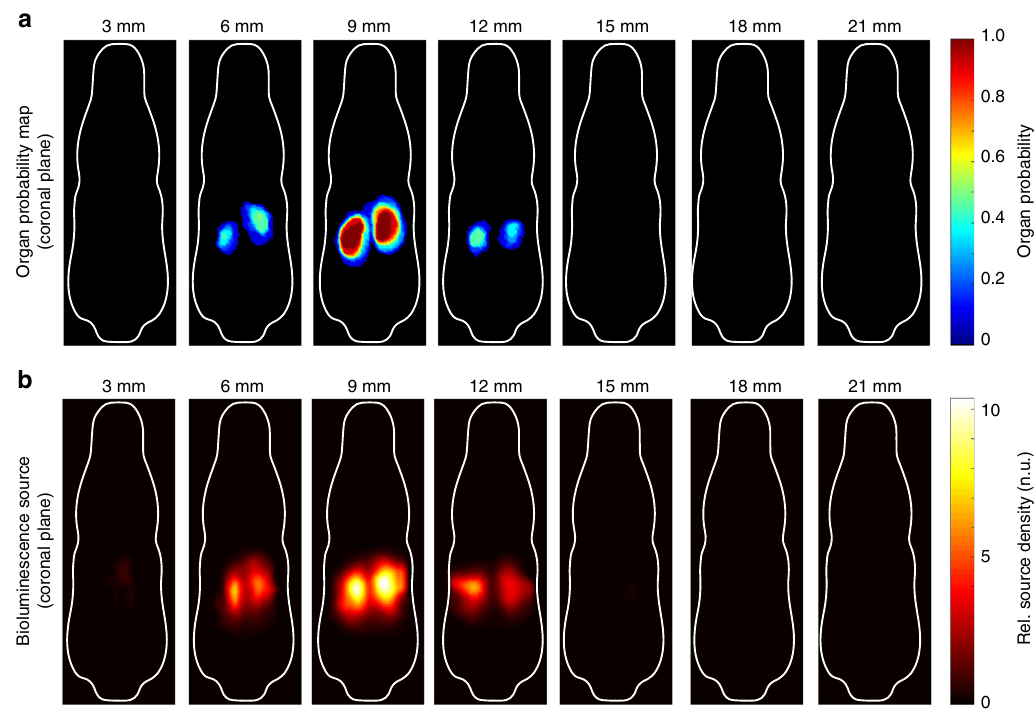
Fig. 7 BLt reconstruction of kidney-speci fi c luciferase reporter mouse and alignment with OPM. a Coronal slices of kidney OPM con fi rm luminescence signal emanating from kidneys. b Coronal slices of reconstructed luminescence source density of a kidney-speci fi c luciferase reporter mouse SLC34a1-R26- Luc . Reconstruction con fi rms ability to delineate two organs in close proximity (left and right reconstruction algorithm for whole-body BLt. InVivoPLOT uni- fi es the in vivo quanti fi cation and automated analysis of biolu-